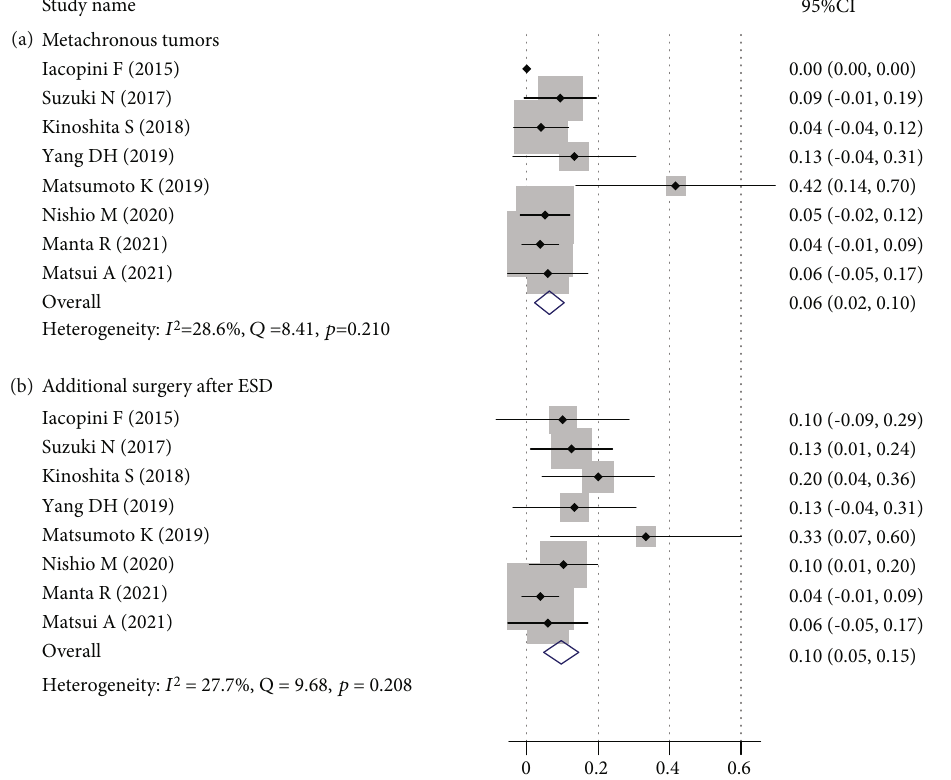
Figure 4: Prevalence of metachronous tumors and additional surgery after endoscopic submucosal